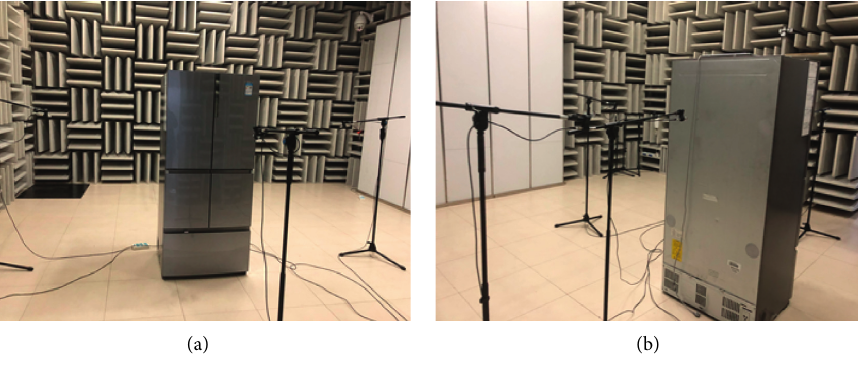
Figure 6: (a, b) Layout of the test